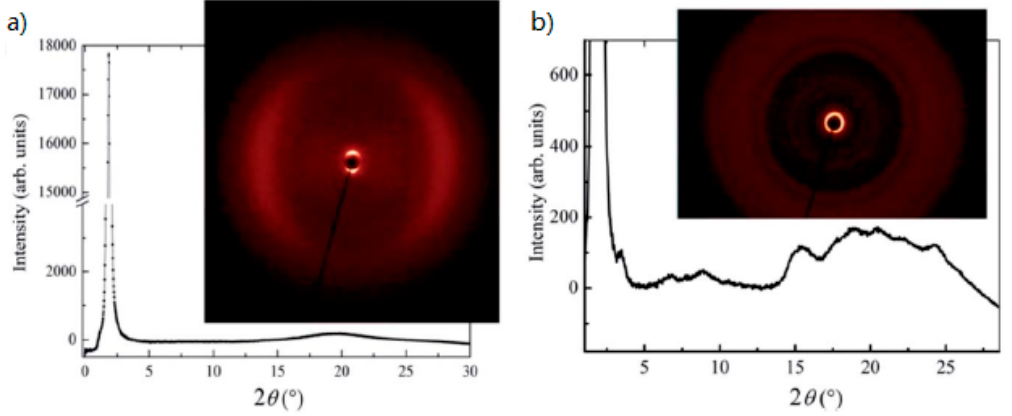
Figure 10. X-ray diffraction (XRD) profile of compound 39a , ( a ) at T = 100 °C in the SmC S1 phase and Figure 10. X-ray di ff raction (XRD) profile of compound 39a , ( a ) at T = 100 ◦ C in the SmC S1 phase